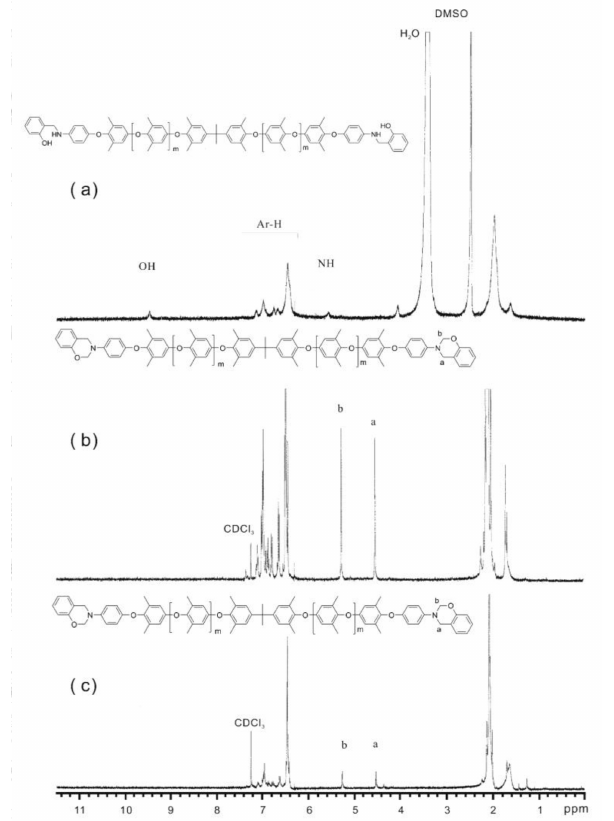
Figure 4. 1 H-NMR spectra of ( a ) intermediate II in DMSO- d 6 , ( b ) P-APPO-2, and ( c ) P-APPO-1 in CDCl 3